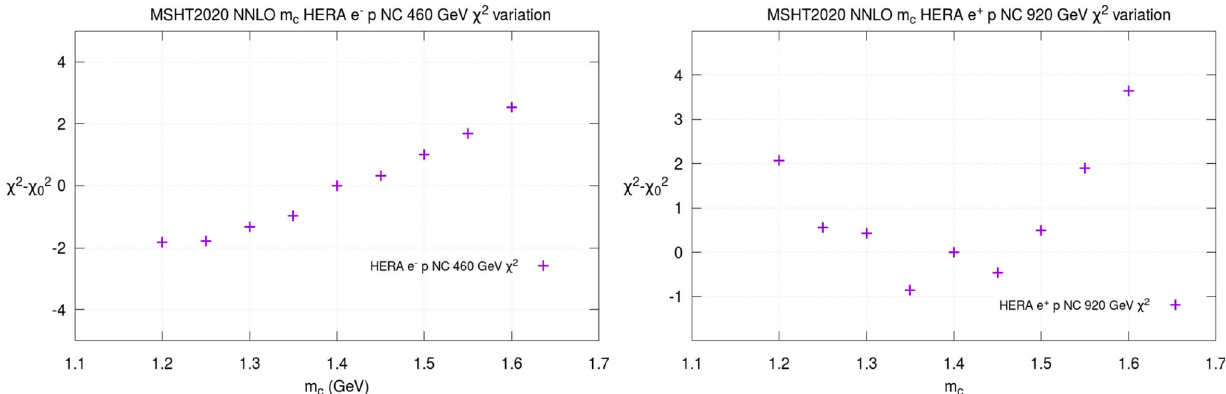
) = 0 . 118 for (left) the total reduced cross section ˜ σ for the combined Z